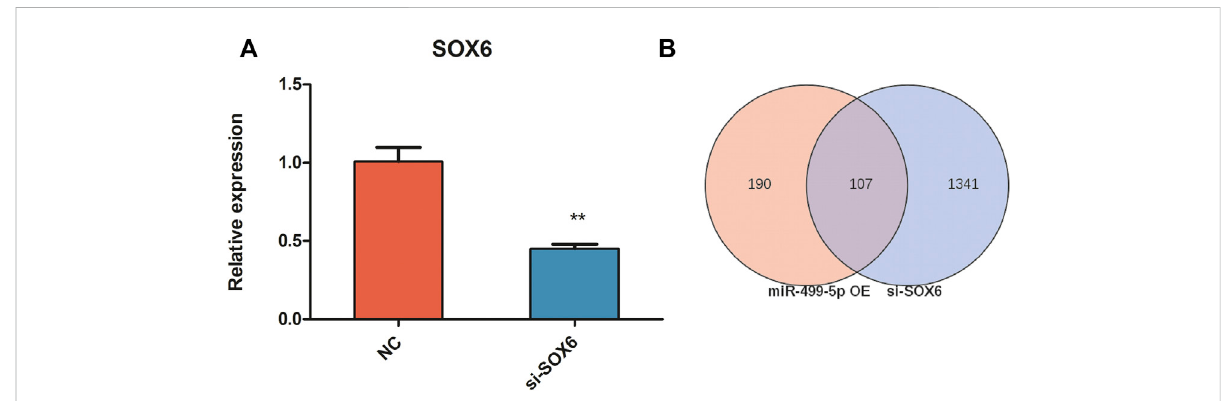
FIGURE 5 The inhibition ef fi ciency ofsi- SOX6 . (A) Therelativeexpression levels of SOX6 in SOX6 knockdownCPMs andnegativecontrol byqRT-PCR. (B) The Venn diagram of differential genes in miR-499 overexpressing and SOX6 knockdown assays. All results are shown as mean ± SD. ** p < 0.01 as compared with the control.